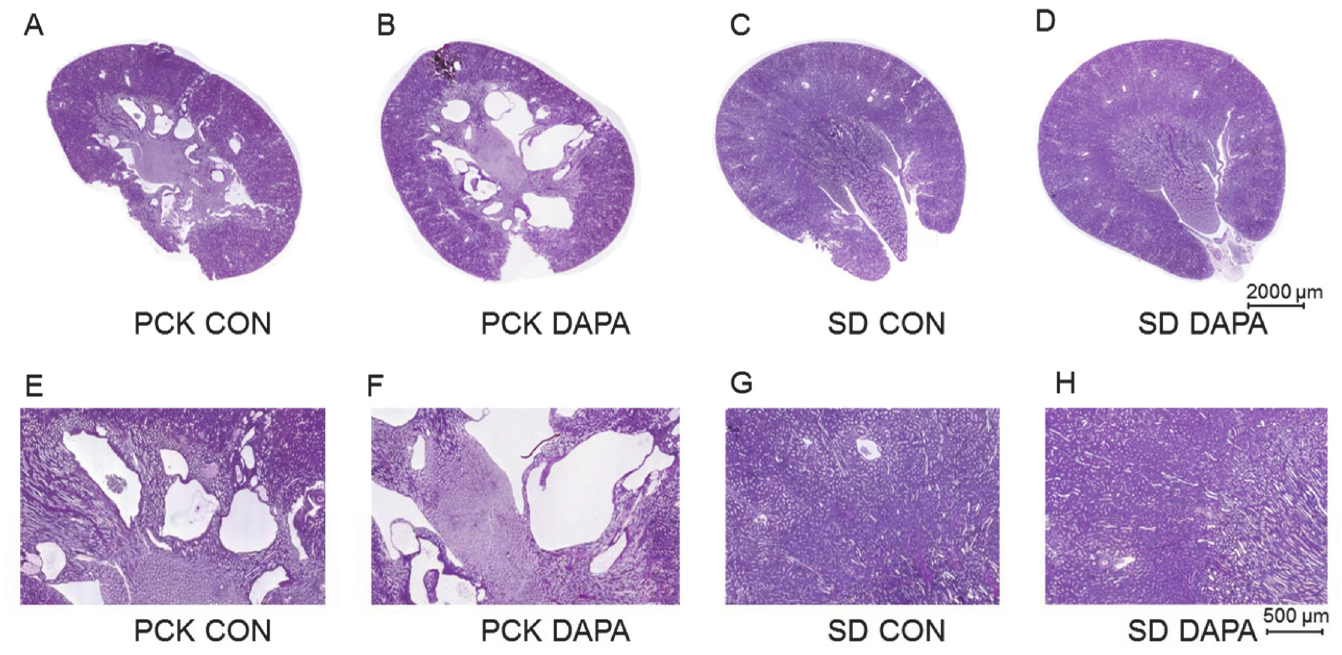
Fig 5. Effect of DAPA on renal histology. Representative renal histology by periodic acid-Schiff (PAS) staining of kidneys in vehicle- treated (CON) PCK (A,E) and normal SD (C,G) rats and in DAPA-treated PCK (B,F) and normal SD (D,H) rats. Scale bar is 2000 μ m in A and B and 500 μ m in C and D.